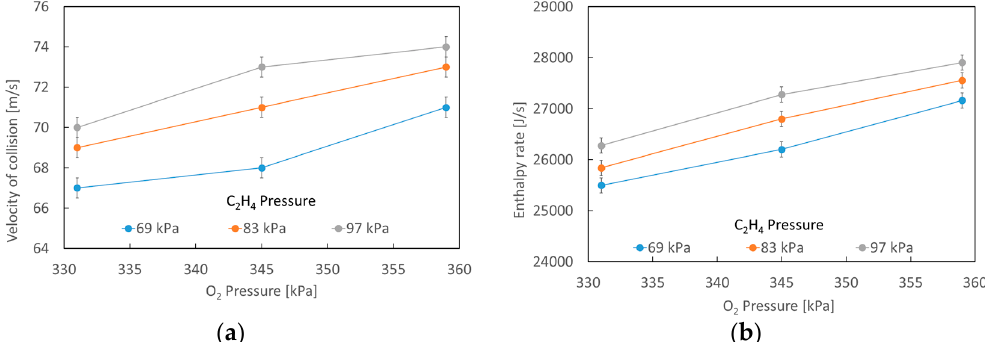
Figure 1. Variation in the velocity of particles colliding with the substrate vs. the variation of oxygen pressure in kPa.